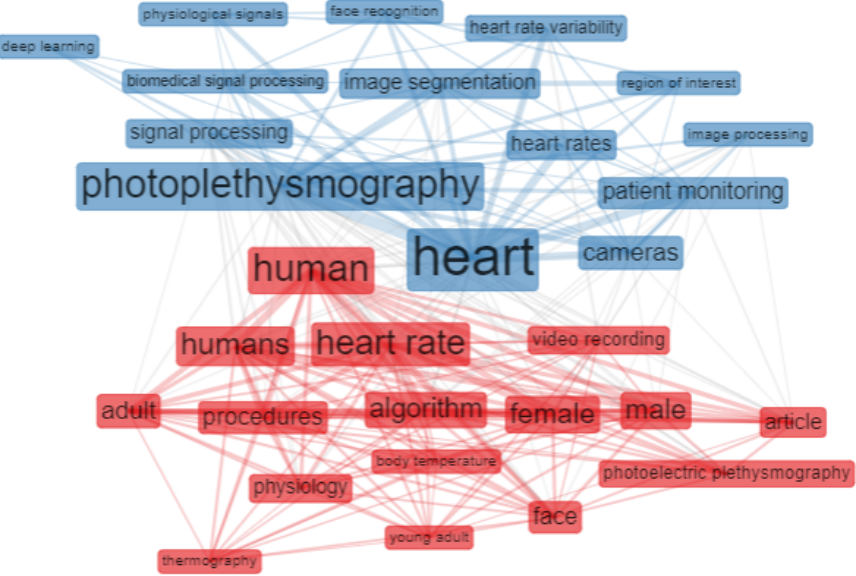
Figure 1. Keyword co-occurrence